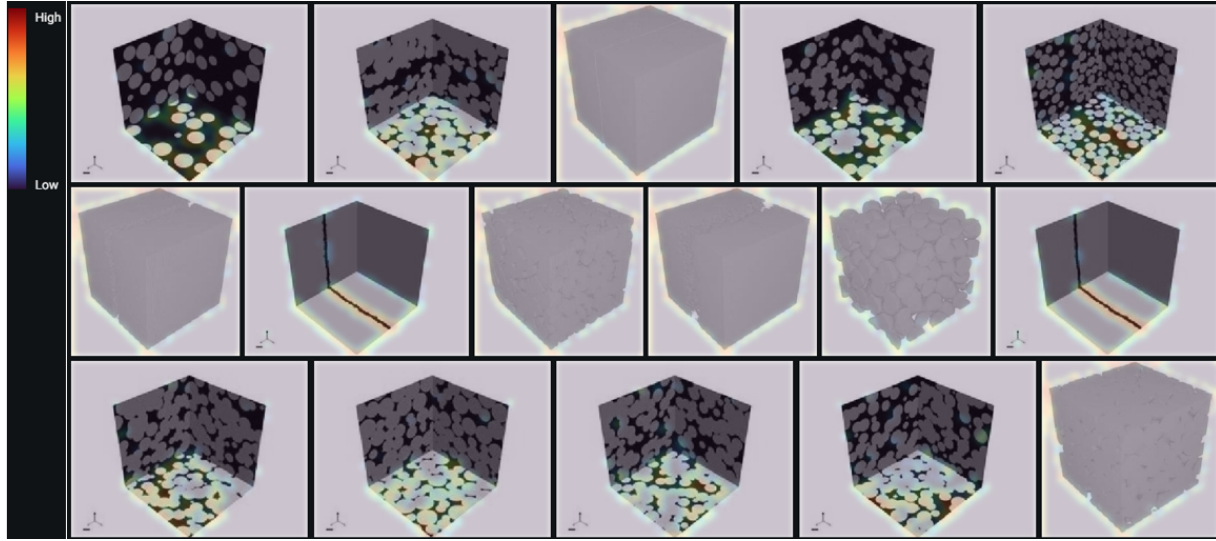
Figure 15. Activation maps visualizing paths (unsupervised).